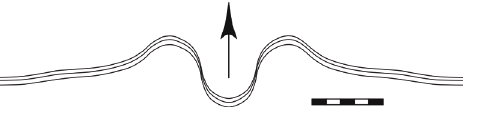
Fig. 65. Lituites kruegeri sp. nov. from the Upper Grey Orthoceratite Limestone; lirae on the venter in holotype MB.C.30539 (Neben & Krueger Coll.) from Hohensaaten (Brandenburg, Germany), at wh = 11 mm. Scale bar units = 1